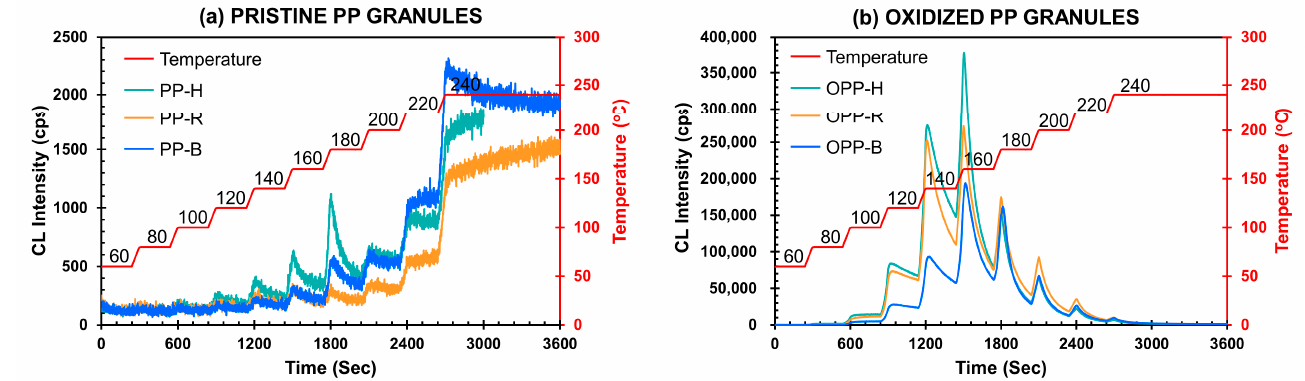
Figure 8. Chemiluminescence intensity of ( a ) pristine and ( b ) oxidized PP granules measured at increments of 20 °C for four minutes from 60 to 240 °C in